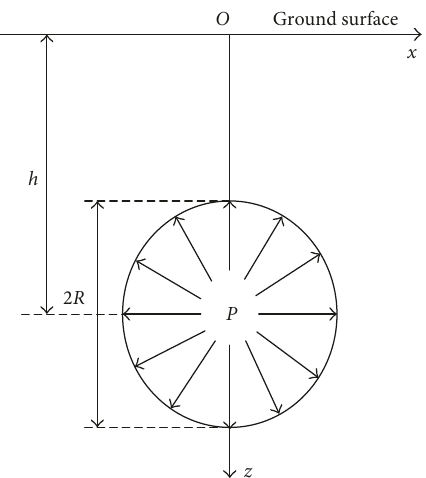
Figure 1: Cylindrical cavity expansion in semi-infinite elastic